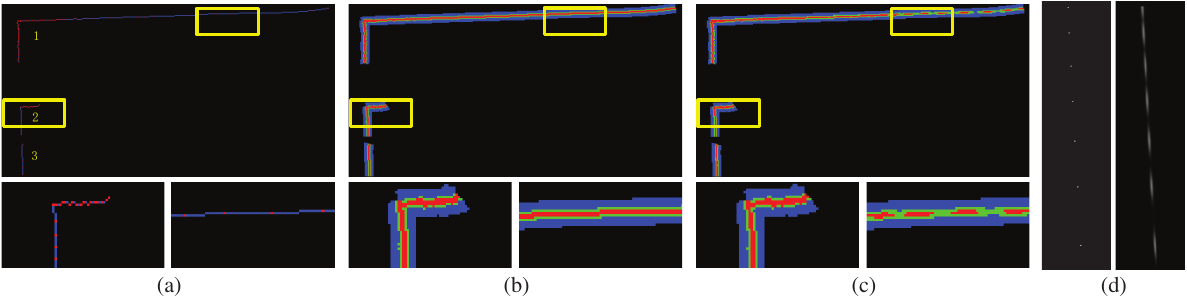
Figure 3: Illustrations of the contour extraction and the occupancy likelihood map generation: (a) three contours in blue extracted from the raw laser measurements alongside the raw laser readings in red dots; (b) the likelihood map generated from the contours by applying a 1-Dimension Gaussian blurring operation along the contour using the method presented in [20]; (c) the occupancy likelihood map generated by our proposed method; (d) a detailed view for our proposed method (Left: the original laser points in a contour; Right: the occupancy likelihood map by applying our propsed 2D Gaussian blurring operation).